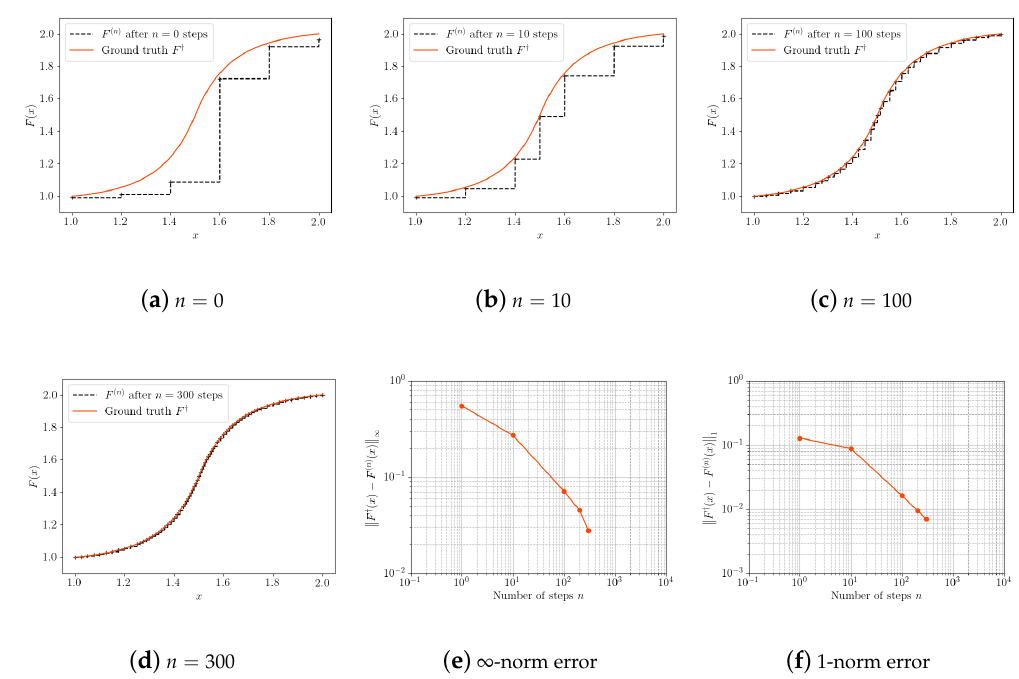
Figure 3. Evolution of F ( n ) and the ∞ - and 1-norms of the error F † − F ( n ) as functions of the iteration count, n , for a smooth ground truth F †